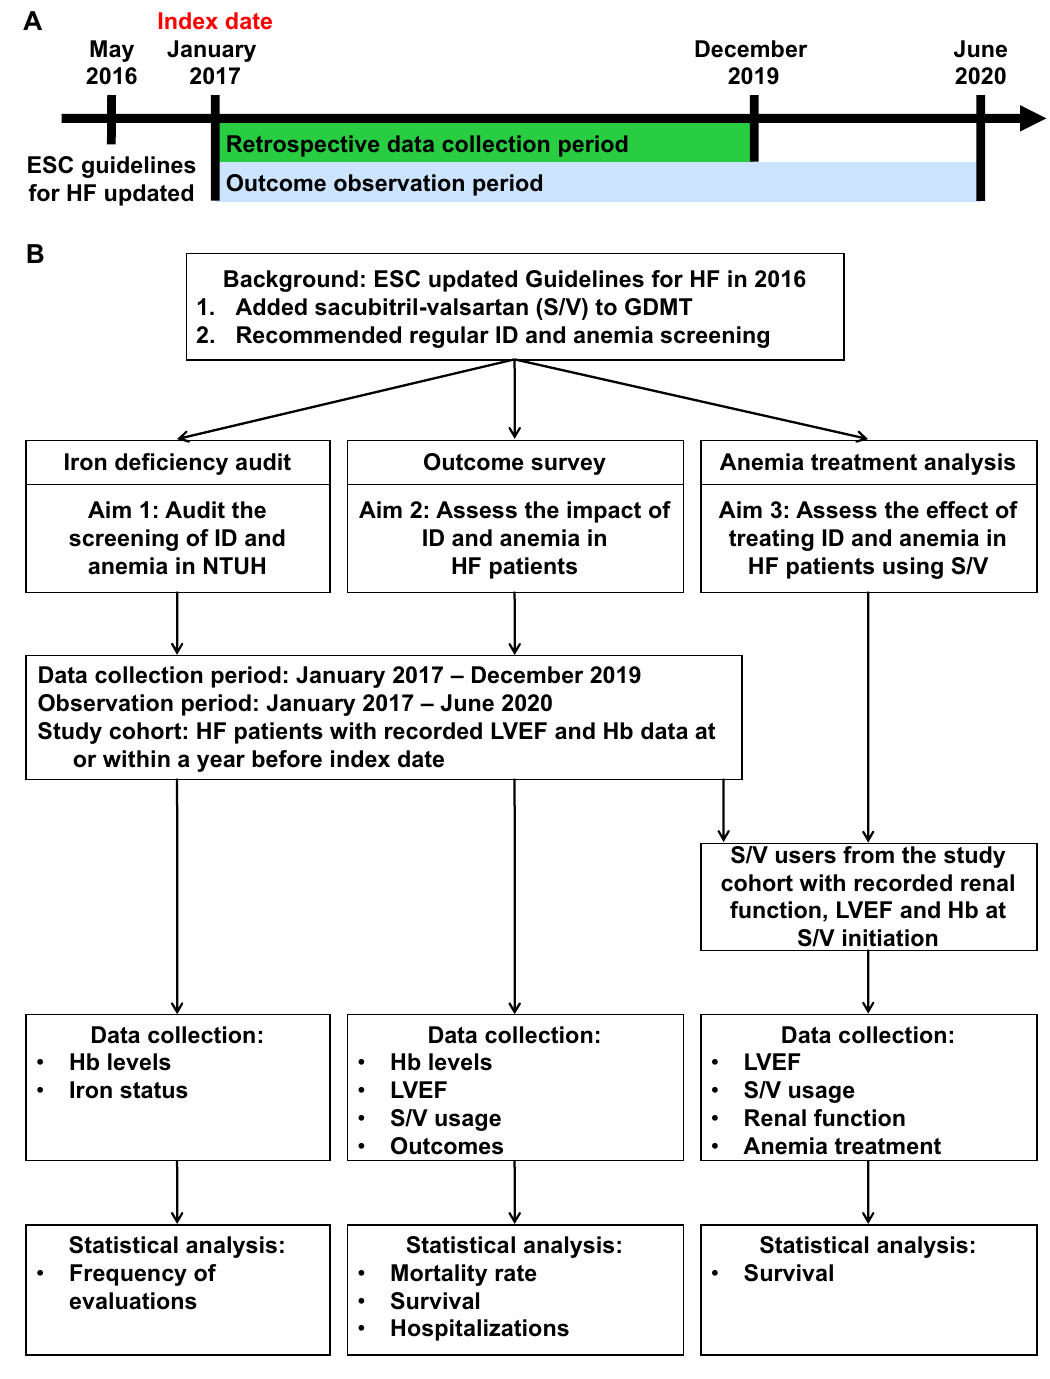
Figure 1. Schematic of study design. First, we executed the ID audit to investigate the frequency with which patients with HF received iron and Hb evaluations. Next, we conducted the outcome survey to investigate the effect of anemia on patients with HF; we noted the mortality, survival, and hospitalization rates and documented LVEF (from January 2019 to June 2020) of the patients. Finally, we performed the anemia treatment analysis to clarify the effects of untreated anemia on patients treated with S/V. ESC: European Society of Cardiology; GDMT: guideline-directed medication therapy; Hb: hemoglobin; HF: heart failure; ID: iron deficiency; LVEF: left ventricular ejection fraction; S/V: